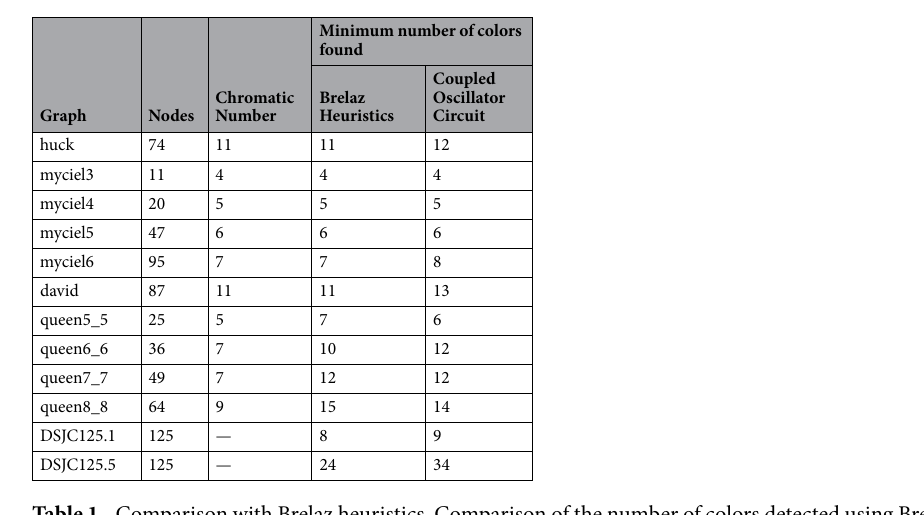
Table 1. Comparison with Brelaz heuristics. Comparison of the number of colors detected using Brelaz heuristics with those detected using a coupled relaxation oscillator circuit for various graph instances from the second DIMACS implementation